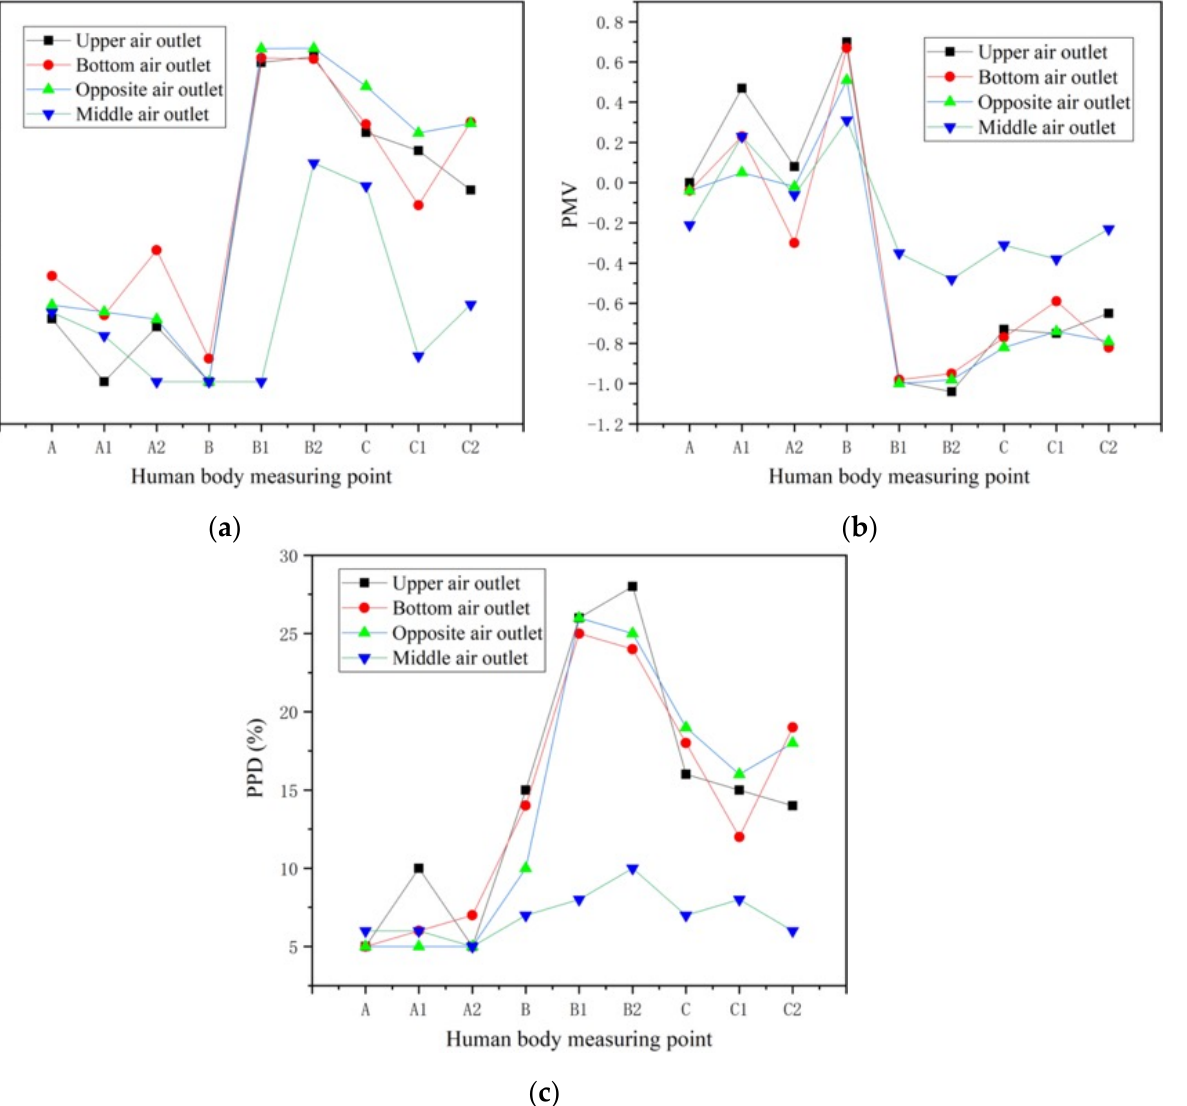
Figure 33. ( a ) The PD in various parts of the body. ( b ) The PMV in various parts of the body. ( c ) The PPD in various parts of the body.